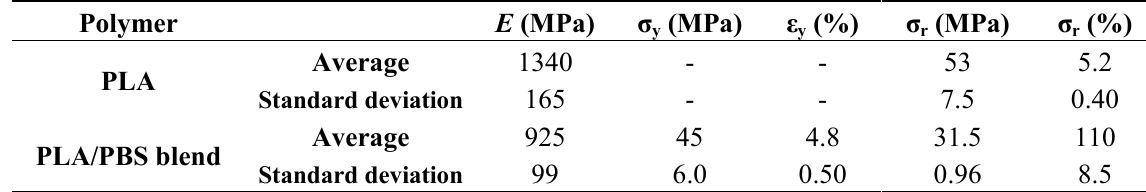
Table 2. Results of tensile tests at 24 °C, on virgin PLA and blend of PLA/PBS (parallel samples).